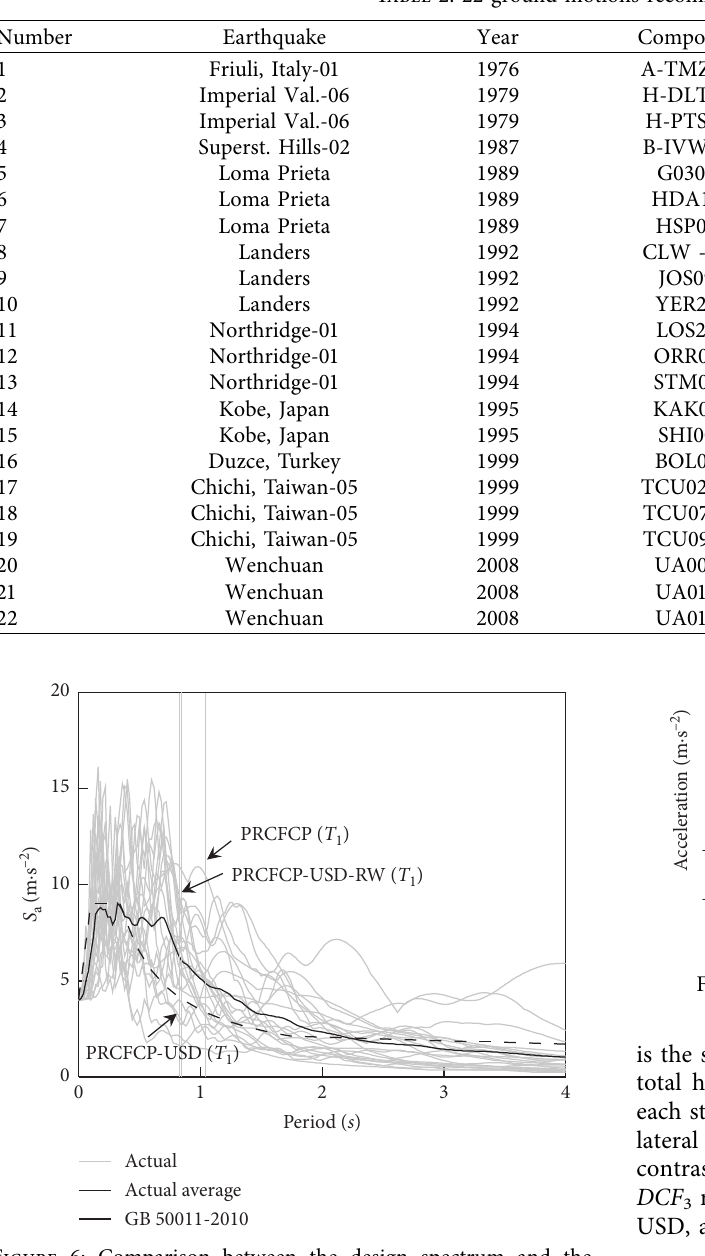
Figure 6: Comparison between the design spectrum and the spectra of actual ground motions.